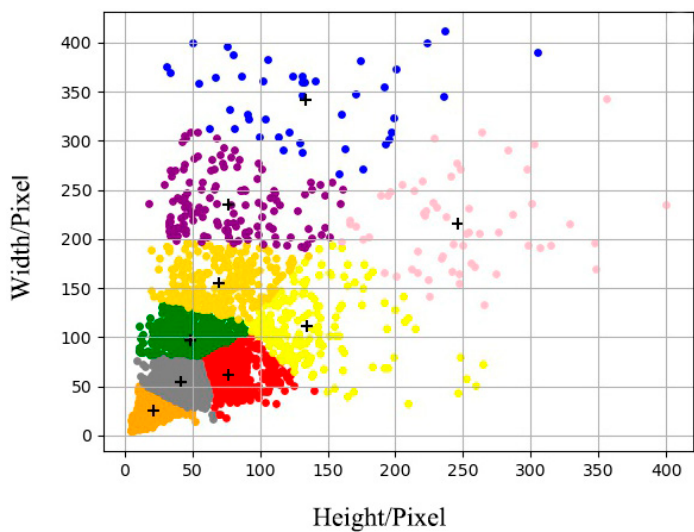
Figure 3. K-means++ algorithm clustering results.